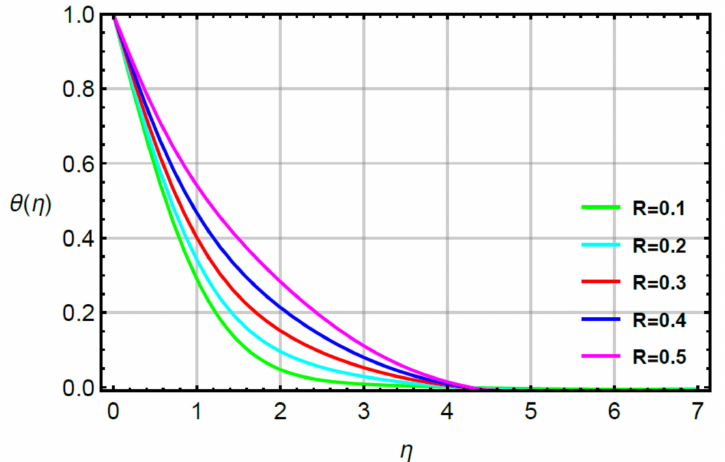
Figure 7. Behavior of θ ( η ) for R when Sc = 0.6, Pr = 1.1, α 1 = 0.2 = α 2 , γ 1 = 0.3 = γ 2 , M = 0.1, δ = 0.8.